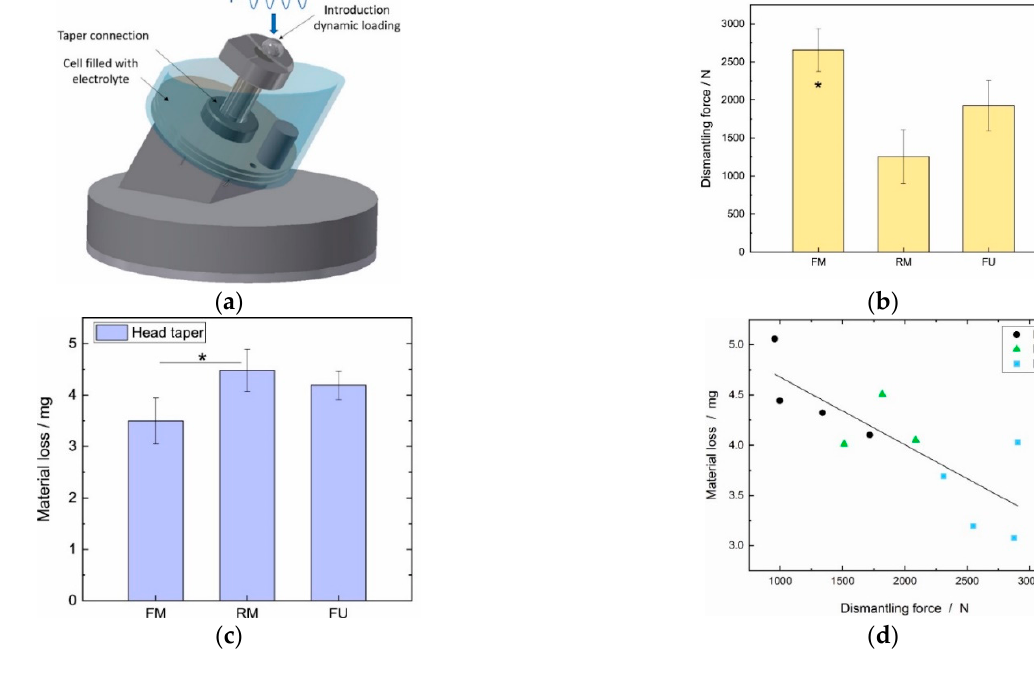
Figure 10. ( a ) Schematic representation of the fretting corrosion tests conducted by Mai et al. [28]. ( b ) The dismantling force after completing the cyclic tests for the three surface topographies. ( c ) The material loss at head taper for the three surface topographies. The asterisk denotes statistically significant differences ( p ≤ 0.05)( d ) The correlation between the material loss at the head taper and the dismantling force after the cyclic tests.